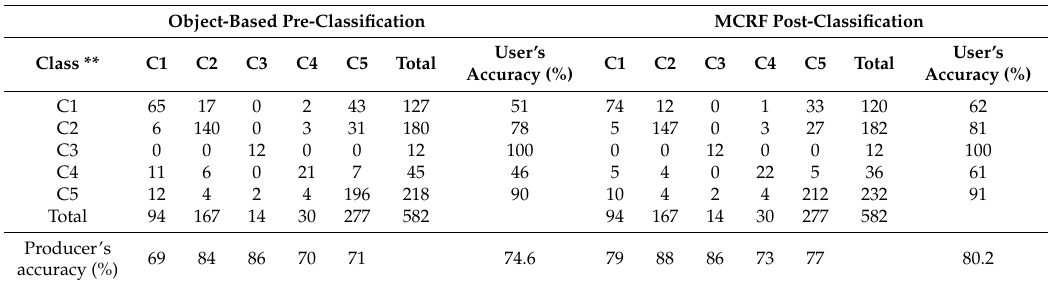
Table 6. Accuracy assessment for pre-classification and corresponding post-classification for the Hartford study area.